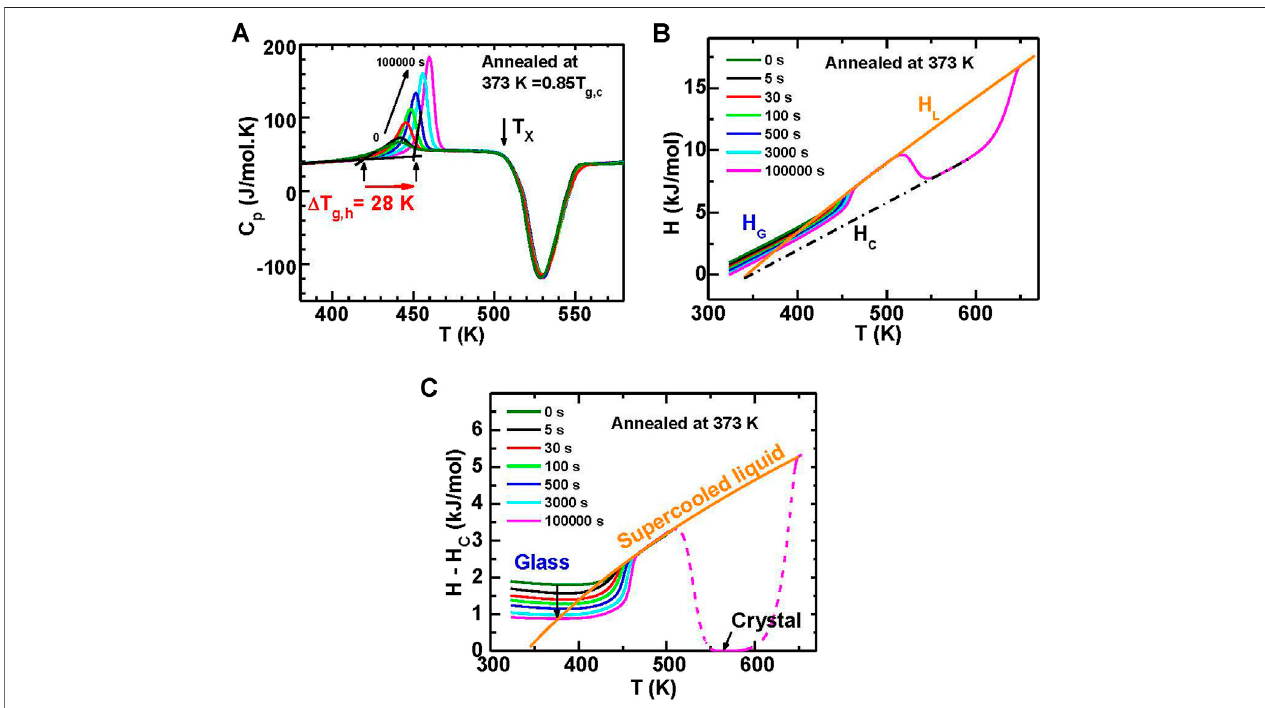
FIGURE 10 | (A) Heat capacity ( C p) for the samples annealed at 373 K ( (cid:2) 0.85 T g,c) for various times (0 – 105 s). The onset glass transition temperature ( T g,h) increases by 28 K from 424 to 452 K after being annealed for 105 s. (B) The enthalpy of annealed samples. (C) The relative enthalpy of annealed samples obtained by subtracting H C. (from (Wang et al.,